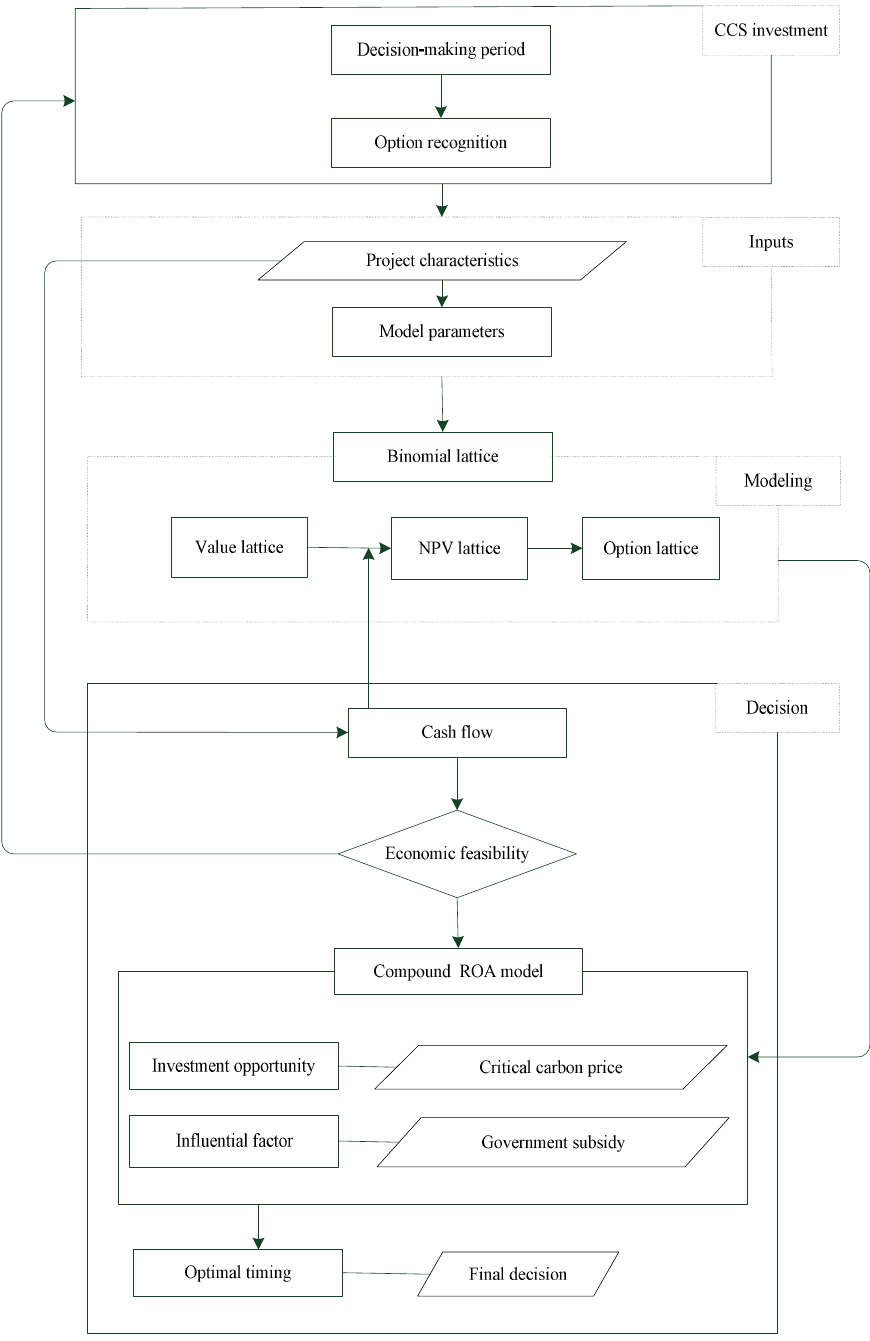
Figure 1. Framework for investment opportunity in CCS retrofit.